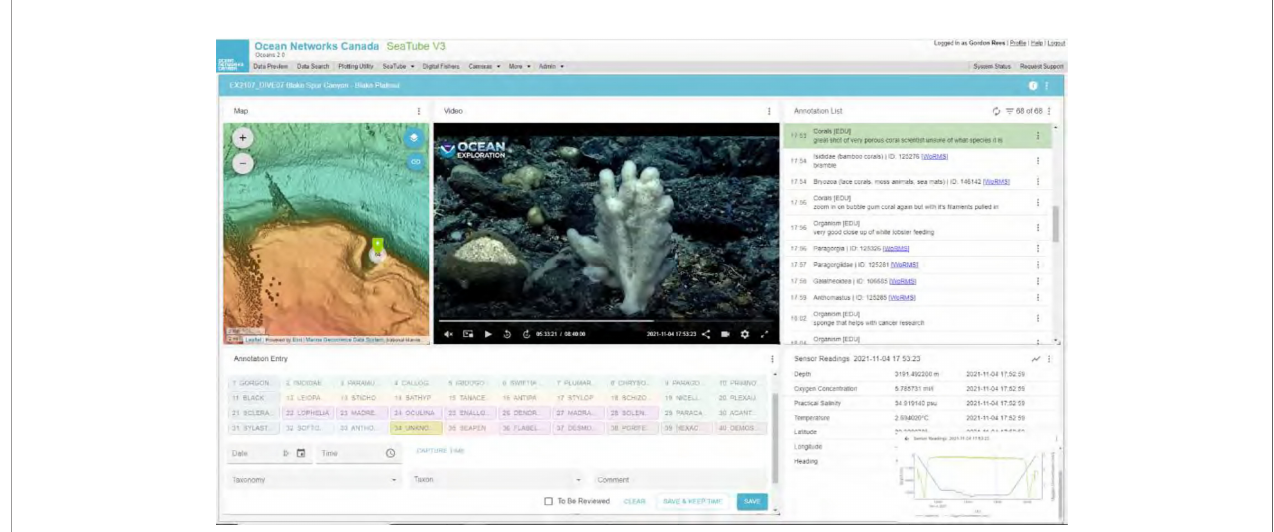
FIGURE 6 | Example of video annotation interface for SeaTube 3.0 showing location of ROV on sea fl oor bathymetry, a deep-sea coral of interest, and the user- designated annotation options available for identifying the coral. Sensor data from the ROV are also linked to the annotation. Screen capture courtesy of NOAA Of fi ce of Ocean Exploration and